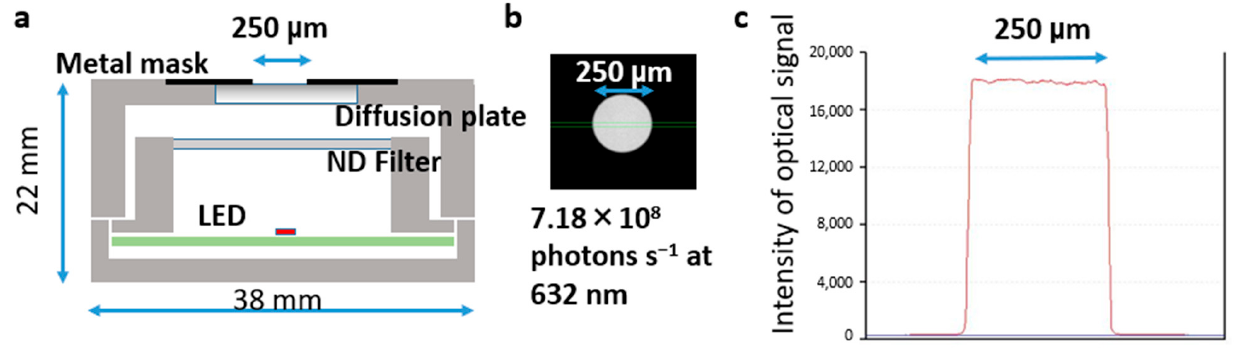
Figure 3. Construct of the LED-based optical reference light source (ref. [53]). ( a ) Schematic illus- tration of the planar light emitting diode (LED) device with a circular aperture in cross-sectional views. ( b ) Absolute optical image of the planar LED with an aperture size of 250 µ m. This LED showed an absolute optical signal of 7.18 × 10 8 photons s − 1 at 632 nm. ( c ) Dispersion profile of absolute optical signal of the planar LED with an aperture size of 250 µ m.